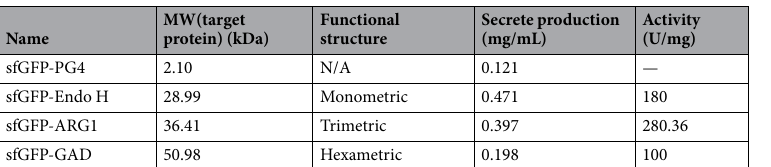
Table 1. Polypeptide and protein used in this